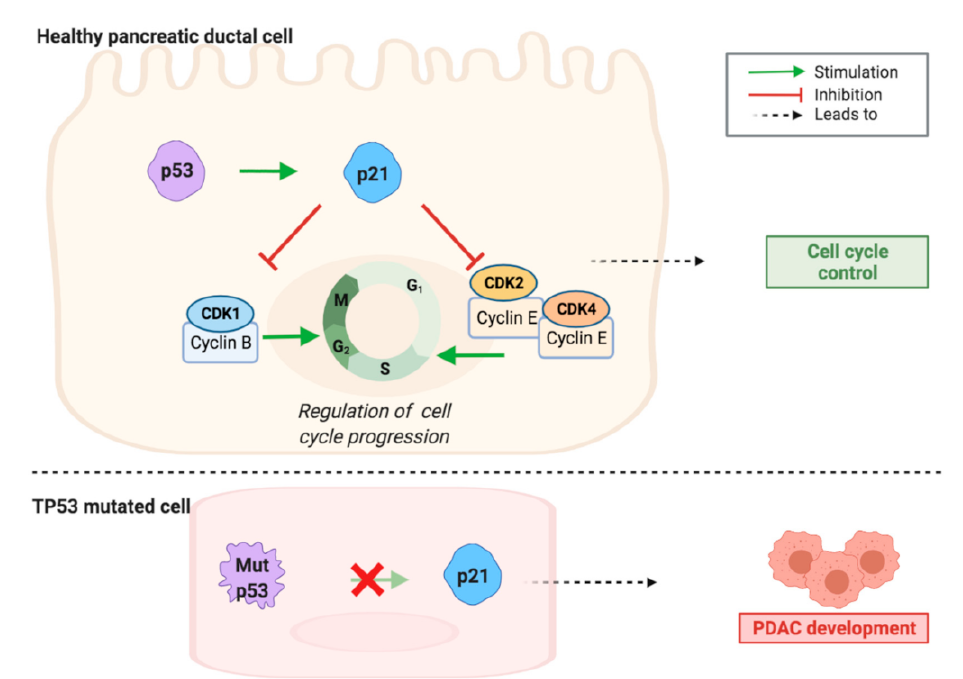
Figure 1. TP53 gene mutation contributes to loss of cell cycle regulation and PDAC formation and development. A healthy cell expresses normal p53, which influences cell cycle control via stimulation of p21, which can inhibit CDK/cyclin complexes. The CDK1/cyclin B complex promotes G2/M phase progression, whereas CDK2/cyclin E and CDK4/cyclin E complexes promote G1/S phase progression. Via loss of CDK/cyclin complexes inhibition, mutated p53 contributes to loss of cell cycle control, which can lead to PDAC